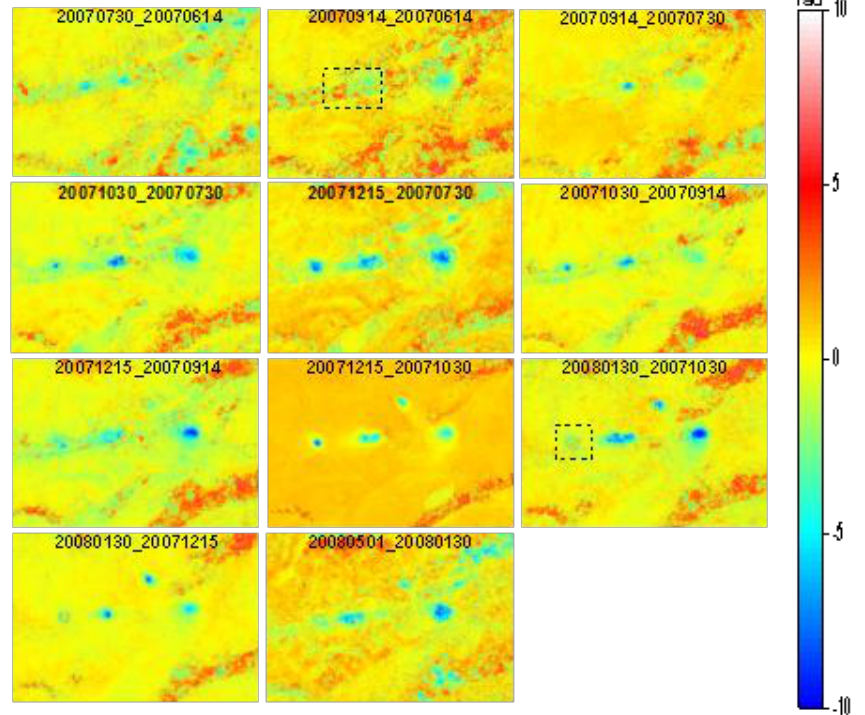
Figure 2.The unwrapped interferograms in